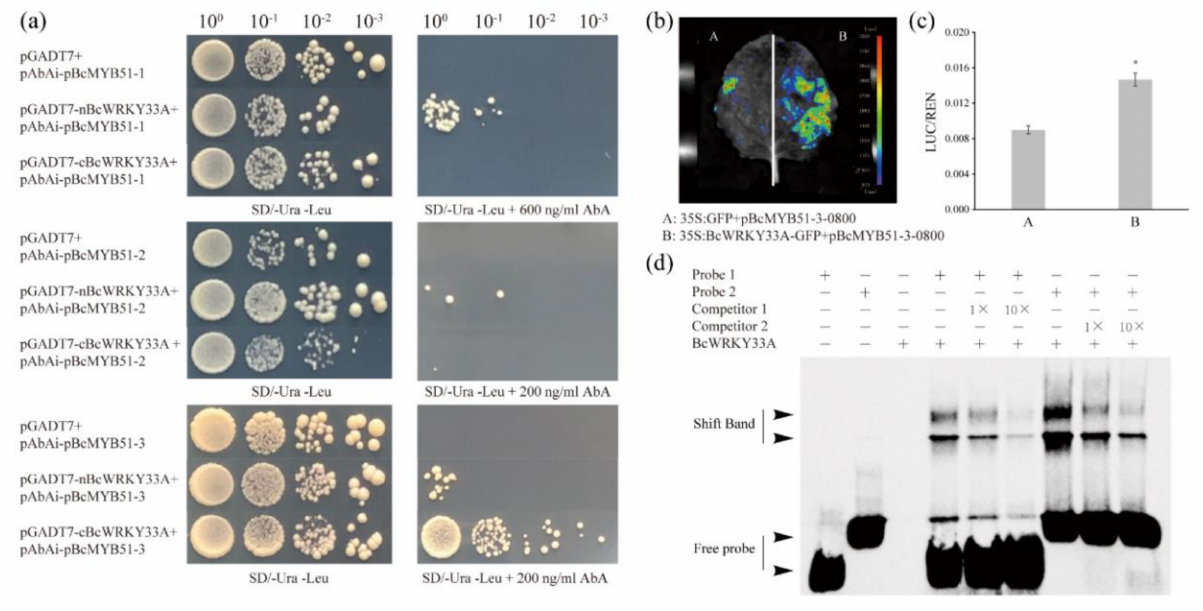
Figure 6. BcWRKY33A directly binds to two W-boxes in the promoter of BcMYB51-3 . ( a ) Y1H showed that BcWRKY33A protein binds to the promoters of BcMYB51-1 and BcMYB51-3 . ( b ) Imaging of LUC activity showed that BcWRKY33A activates the expression of BcMYB51-3 . ( c ) The ratio of LUC/REN of ( b ). ( d ) EMSA showed that BcWRKY33A protein binds to the two W-box elements in the promoter of BcMYB51-3 . The experiments were performed twice with similar results. Error bars represent SD. The data are the mean ± SD of three biological replicates. * p < 0.05 (Student’s t